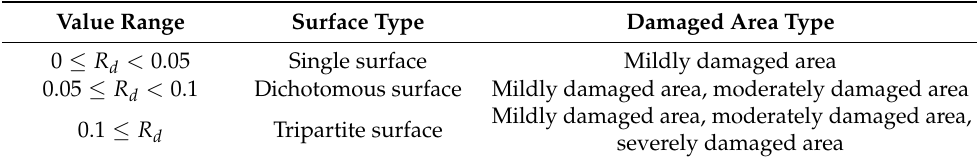
Table 5. Regional basis according to R d .